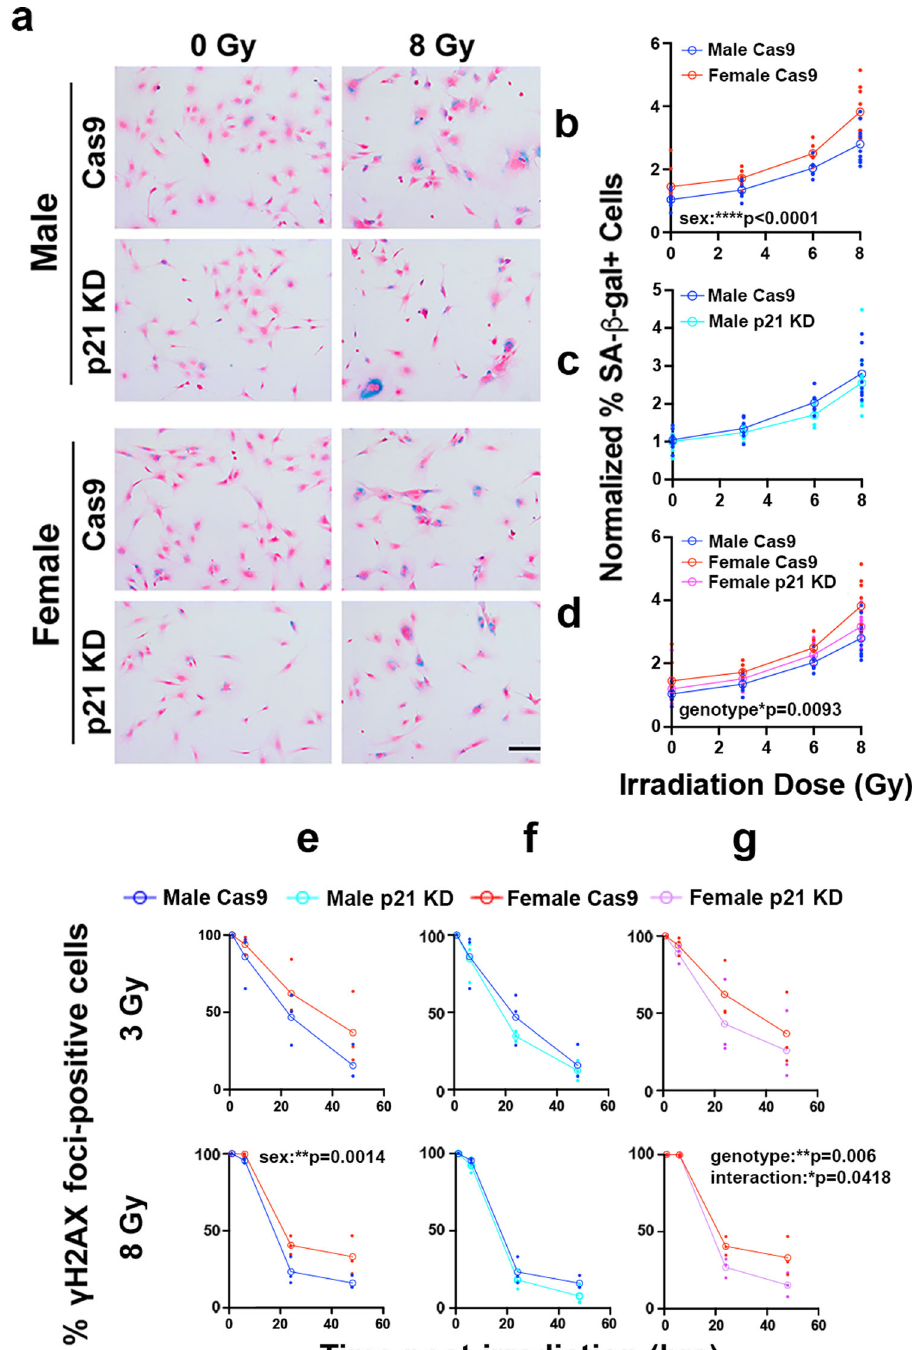
cells by p21 KD (Fig. 7g) to male comparable levels. There was a trend towards an effect of p21 KD in female cells irradiated with 3 Gy, however this did not reach statistical signi fi cance. Together, these data support the idea that p21 expression contributes signi fi cantly to the levels of senescence after irradiation in females, but not in males. Notably, despite the decrease in SA- β - gal in female p21 KD cells, they still retain a signi fi cant senescence response, and in fact decrease only to the levels of senescence in male cells. This suggests that additional pathways, beyond p21, are contributing to senescence after irradiation in both male and female